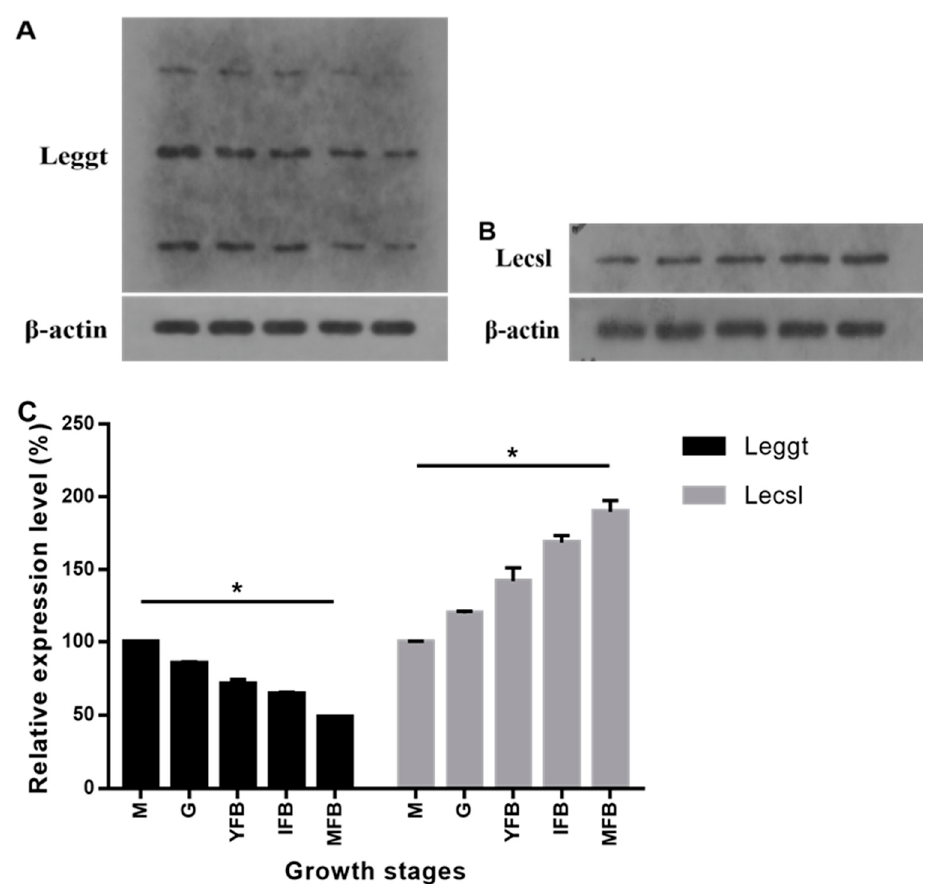
Figure 3. ( A ) Protein levels of Leggt at five stages of growth. ( B ) Protein levels of Lecsl at five stages of growth. ( C ) Relative expression of Leggt and Lecsl during five growth stages. β -actin protein was used as loading control, and the expressions during the M stage were taken as 100%. M, mycelia; G, grey; YFB, young fruiting body; IFB, immature fruiting body; MFB, mature fruiting body. Error bars indicate standard deviation for three independent experiments. * p < 0.05, ANOVA tests by Duncan’s indicate significant differences.